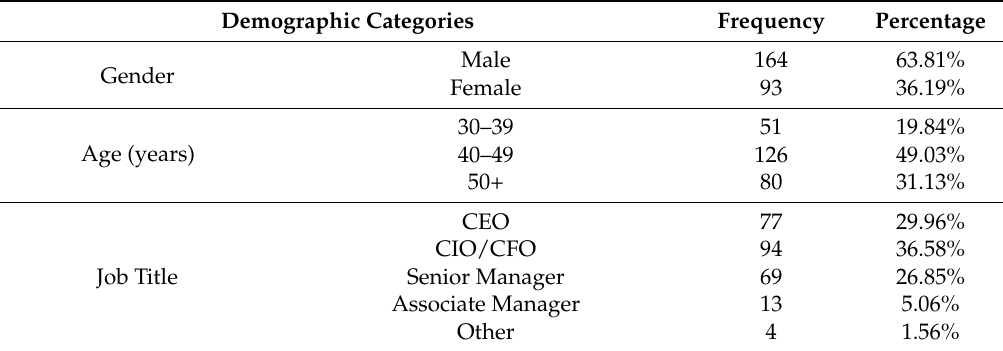
Table 1. Demographic characteristics (n =